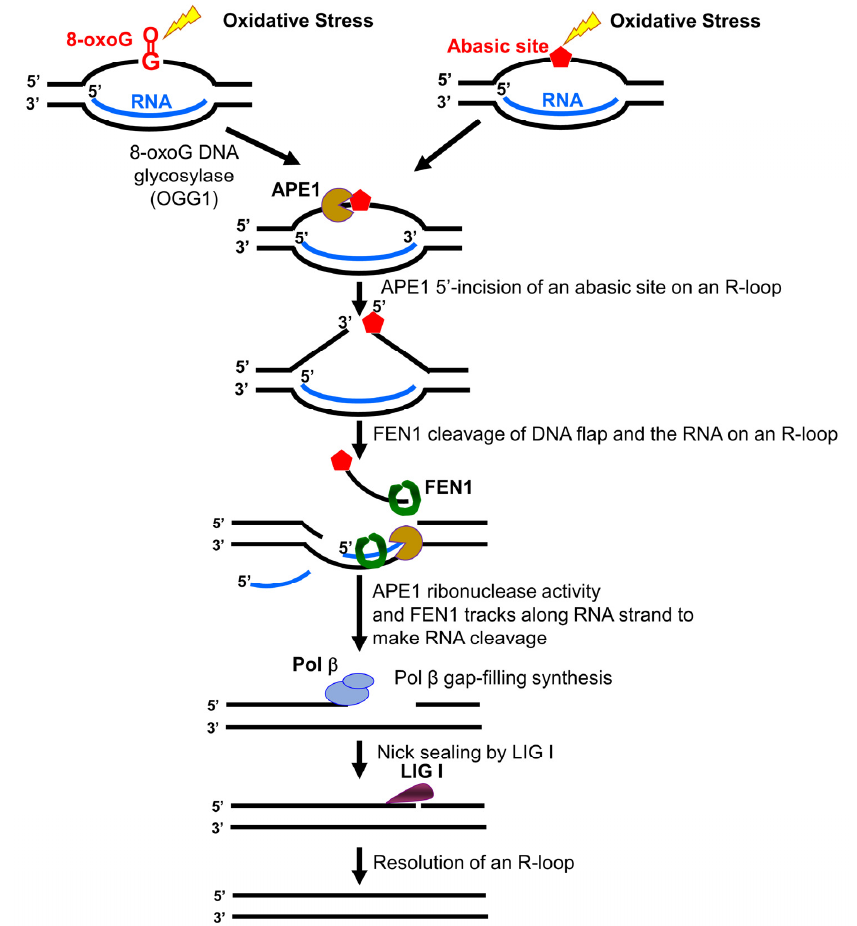
Figure 10. FEN1 and APE1 coordinate to cleave RNA and resolve an R - loop via BER. Oxidative stress induces DNA base lesions such as 8-oxoGs and abasic sites in the non-template strand of an R - loop. 8-oxoG DNA glycosylase (OGG1) removes the 8 - oxoG leaving an abasic site that is subsequently 5 ′ -incised by APE1. This incises the non-template strand converting the R-loop into a double-flap with a RNA:DNA hybrid. The downstream 5 ′ -DNA flap is removed by FEN1. This allows FEN1 and APE1 to access the RNA strand in the R - loop. FEN1 endonucleolytically cleaves RNA from the 5 ′ - side, whereas APE1 exonucleolytically removes ribonucleotides from the 3 ′ - end of the RNA. The removal of the RNA by the coordinated cleavage activity of FEN1 and APE1 allows the reannealing of the upstream flap to the template strand leaving a gap. Pol β then fill in the gap generating a nick that is sealed by LIG I. This leads to the completion of BER of the base lesions and the resolution of the R - loop.